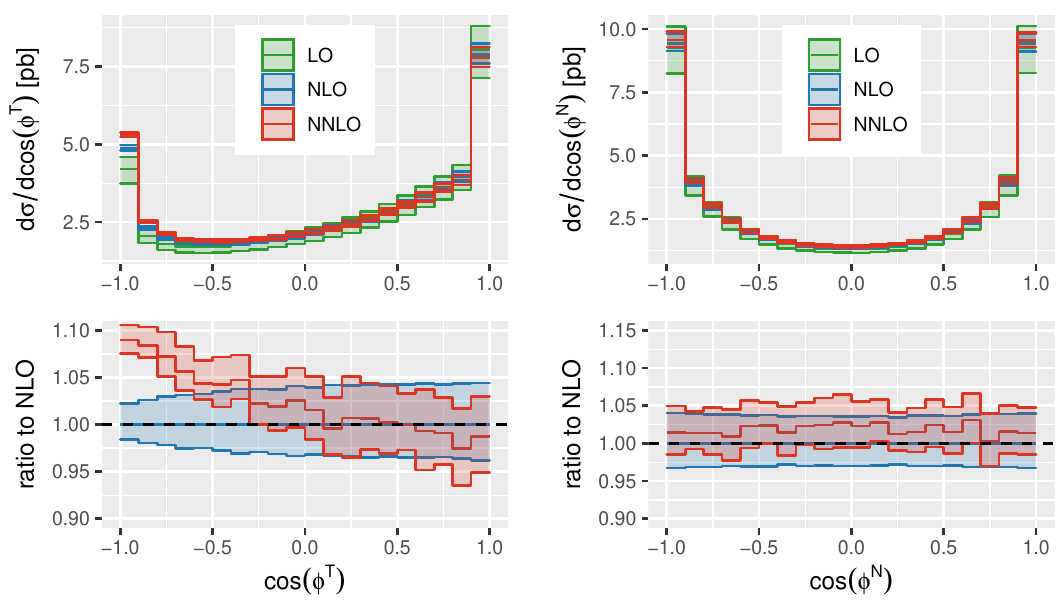
(left) and cos θ T l